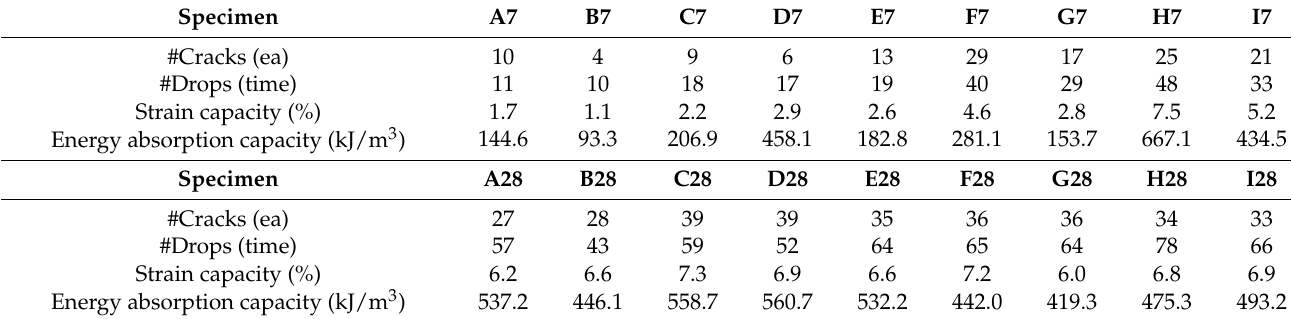
Table 4. Test indexes for tensile and cracking behaviors of